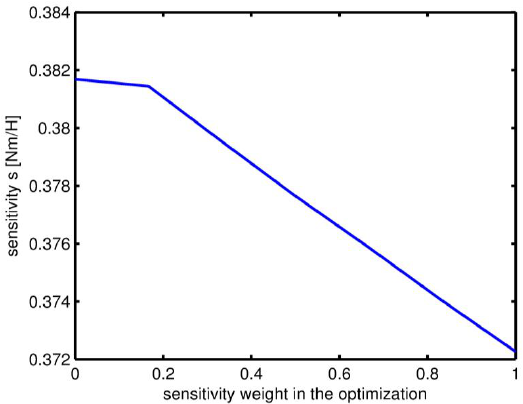
Figure 11. Sensitivity value versus weight γ s .